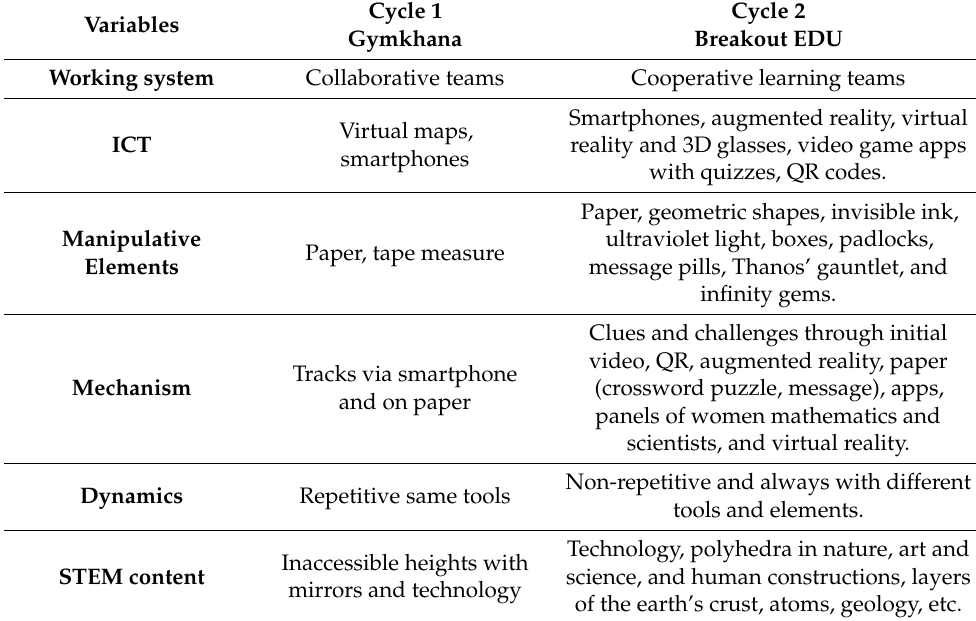
Table 5. Comparative final evaluation of first and second action research